Question: Does the plotted quantity increase or decrease?
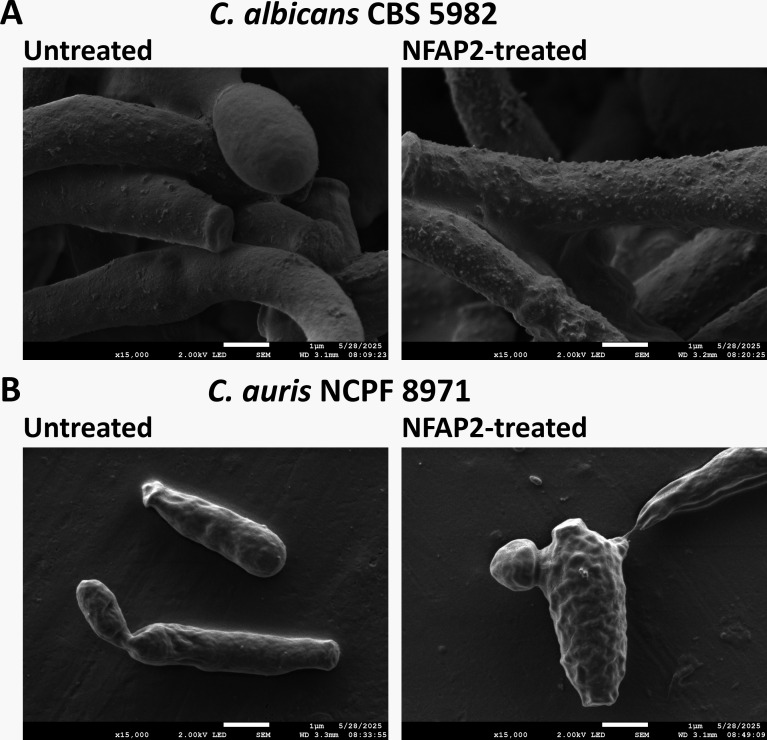
Answer: increasing